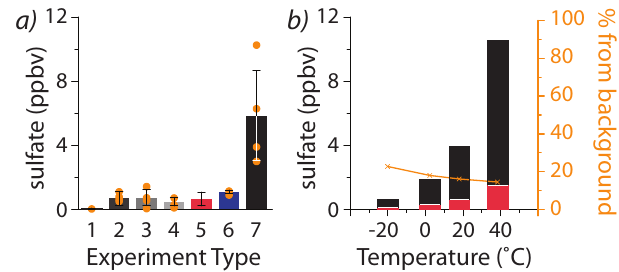
Fig. 2. Quantification of background in the reaction of SO 2 and OH. (a) Total sulfate collected at room temperature under various conditions (individual samples are shown as orange dots, error bars are 1 σ standard deviation of individual samples): (1) Background from impurities in MilliQ water and BaCl 2 ; (2) Direct photolysis of SO 2 , 254nm and 185nm lines; (3) Direct photolysis, 254nm line; (4) 254nm and 185nm lines, humidity passing over lamp; (5) 2–4 combined to show total production under UV light in the absence of OH; (6) no irradiation, no added oxidant; (7) 11ppbv OH. (b) Temperature-dependence of sulfate production from OH reaction (black) and background from sulfate impurities in water (white) and background production (red), with the percentage contribution of the background to total collected shown in